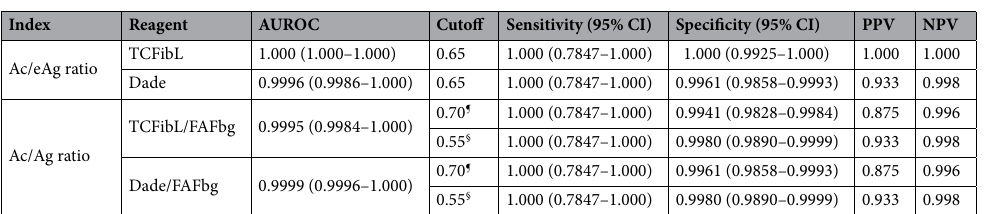
Table 3. Predictive accuracies of Ac/Ag ratio and Ac/eAg ratio for qualitative fibrinogen defect in validation cohort. AUROC, area under the receiver-operating characteristics curve; CI, confidence interval; PPV, positive predictive value; NPV, negative predictive value; Ac, functional fibrinogen concentration; Ag, antigenic fibrinogen concentration; eAg, estimated Ag; TCFibL, Thrombocheck FibL reagent; Dade, Dade Thrombin Reagent; FAFbg, FactorAuto Fibrinogen. ¶ Cutoff value suggested by Krammer et al 30 . § Cutoff value proposed in the current study.